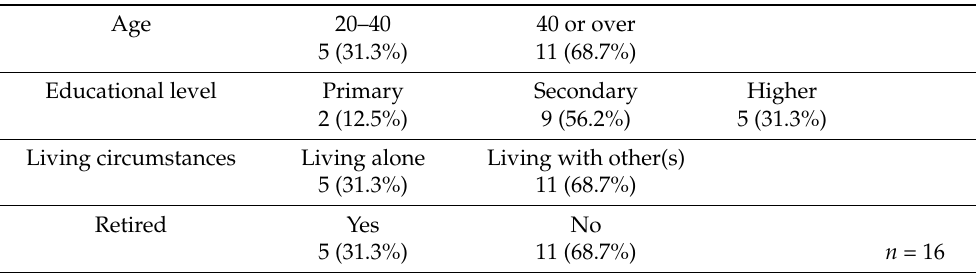
Table 2. Sociodemographic data for patients with